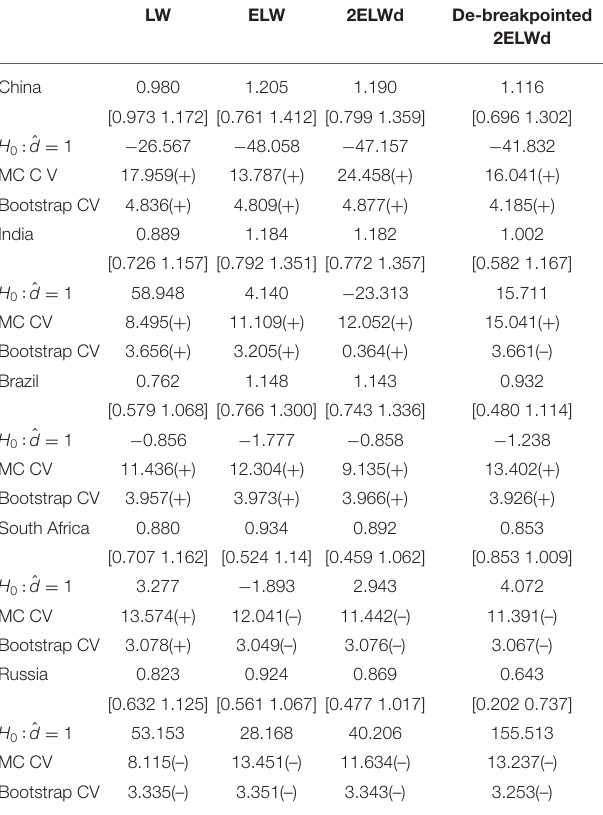
TABLE 3 | Long memory parameter estimates of per capita BCs in BRICS. TABLE 2 | Long memory parameter estimates of per capita EFs in BRICS. LW ELW 2ELWd De-breakpointed LW ELW 2ELWd